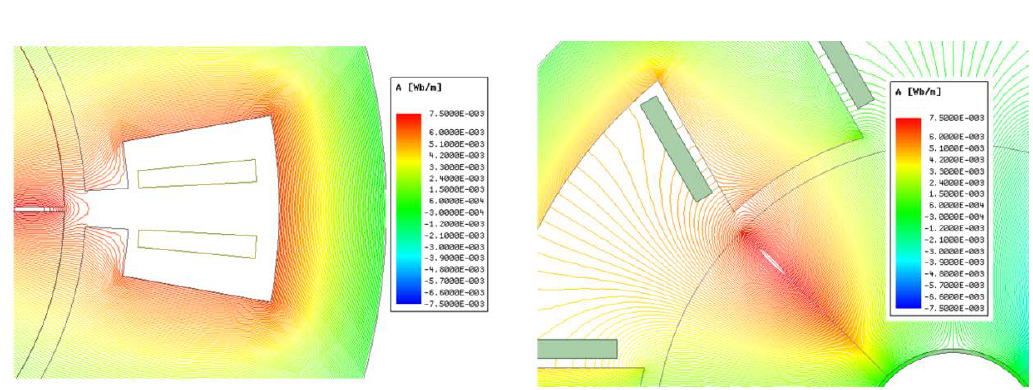
Figure 7. Distribution of stator magnetic field flux lines.